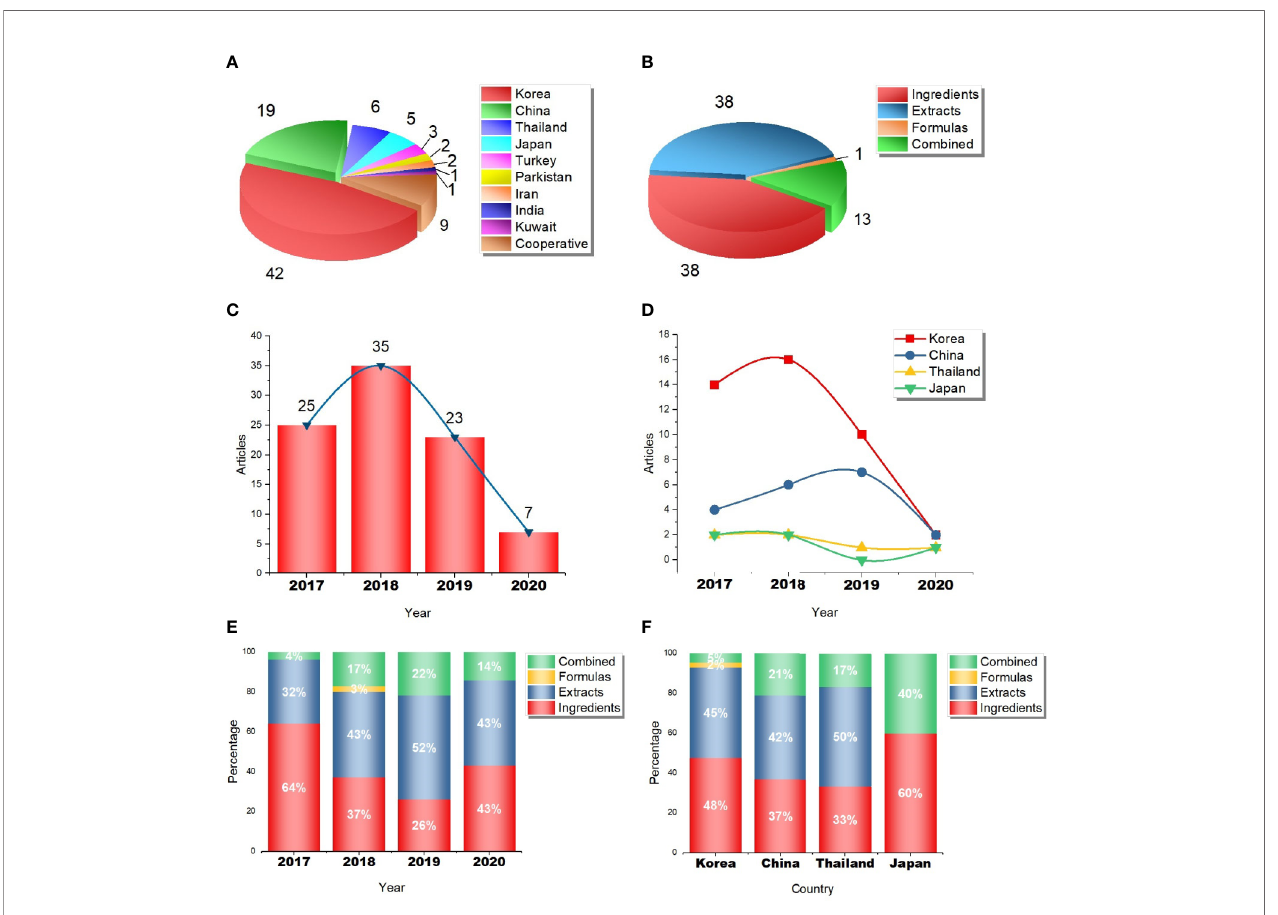
FIGURE 1 | Overview of 90 Asian herbal studies in skin whitening. (A) The number of studies in different countries; (B) the number of studies on different reagent types; (C) the number of studies from 2017 to 2019; (D) the studies in four countries from 2017 to 2019; (E) the percentage of different reagent types from 2017 to 2019; (F) the percentage of different reagent types in four